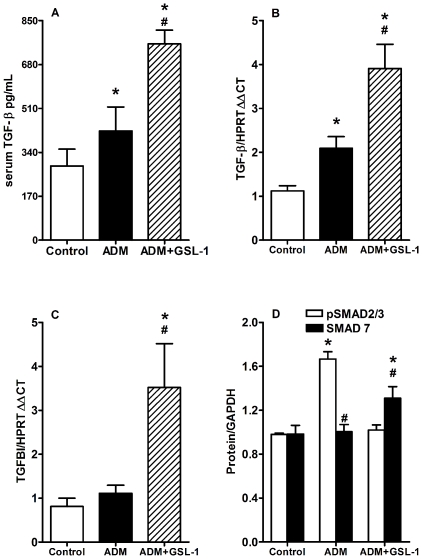
GSL-1 treatment modulates TGF-β signaling.BALB/c mice were injected at day 0 with 10 mg/kg of adriamycin (ADM) or treated concomitantly with ADM and 5 µg/mouse GSL-1 (ADM+GSL-1). (A) Total TGF-β protein increased in the serum of both the ADM and ADM+GSL-1 groups compared with the control animals. (B) The increase in TGF-β transcripts in kidney tissue reflected the serum findings showing that the ADM and ADM+GSL-1 groups had higher levels of this cytokine compared with the control mice. GSL-1 treatment induced a more significant increase in serum TGFβ and mRNA transcripts compared with the ADM group; however, only ADM+GSL-1 mice presented transcripts to the TGFBI/BIGH3 protein (C), indicating that TGF-β production had a different effect in this group. This idea is supported by the presence of phosphorylated SMAD2/3 in ADM mice, whereas in the ADM+GSL-1 group, the expression of SMAD7 protein increased (D). These data indicate that GSL-1 treatment modulated the downstream cascade of TGF-β signaling. * p<0.05 vs. control; # p<0.05 vs. ADM.